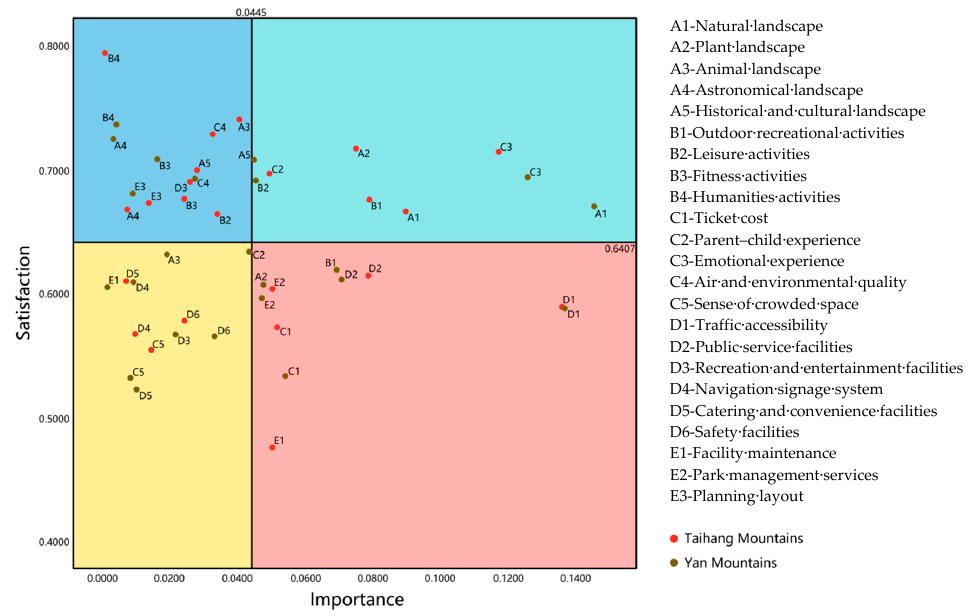
Figure 21. IPA of satisfaction with recreation in different mountain systems.